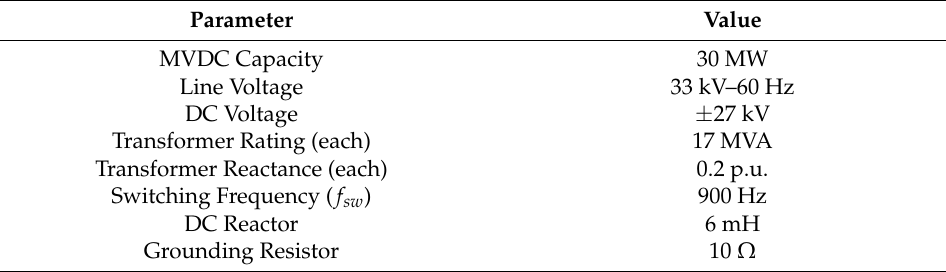
Figure 8. The developed MVDC system topology. Table 1. Specifications of the developed MVDC